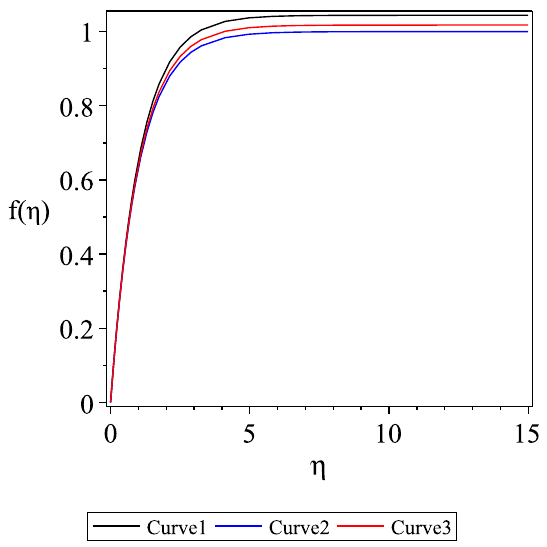
Fig. 5 Plot of (cid:98) f ( η ) , where Curve 1 has Le = 2, Nb = 2, Pr = 1, Nt = 1, n = 0 . 5, Curve 2 has Le = 3, Nb = 1, Pr = 5, Nt = 0, n = 1, and Curve 3 has Le = 2, Nb = 2, Pr = 7, Nt = 0 . 5, n = 0 . 8 using their respective error-minimizing convergence control parameter.